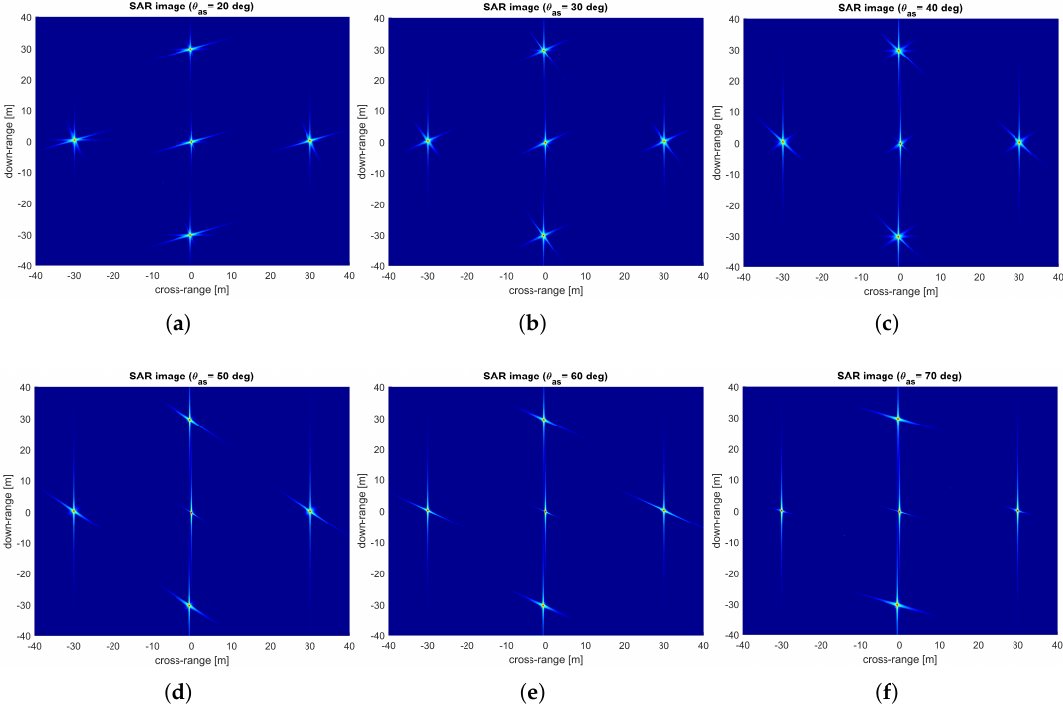
Figure 22. SAR video frames after image rotation at aspect angle: ( a ) 20°; ( b ) 30°; ( c ) 40°; ( d ) 50°; ( e ) 60°; ( f )